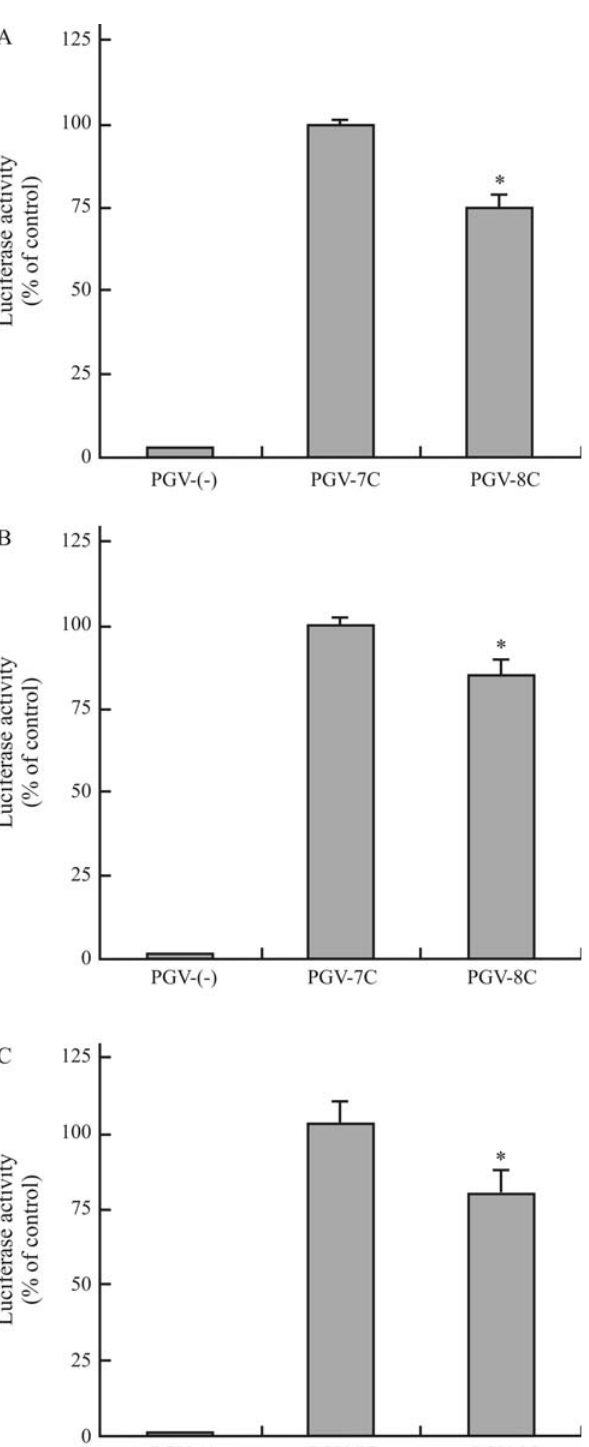
Figure 6 - Effects of the p53 poly(C) polymorphism on luciferase activity in different cell lines. (A-C) Colo320DM (A), U251 (B), and T98G (C) cells were transfected with the indicated vector constructs of PGV-(-), PGV-7C, and PGV-8C. The transfected cells were cultured for 24 h, and luciferase activity was determined. Data are shown as percentages of val- ues obtained from the PGV-7C transfectants and are expressed as the mean (cid:5) SEM (n = 8). *: Significant difference compared with the PGV-7C transfectant.